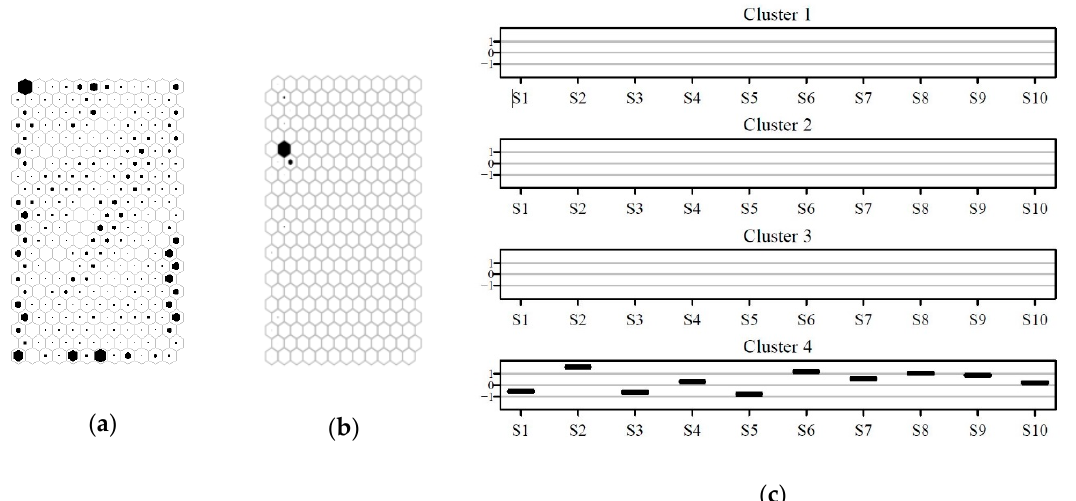
Figure 10. ( a ) Distribution of the building data on the map and ( b ) distribution of the external data on the map. The filling of each hexagon is proportional to the number of data mapping on the best matching unit (BMU) represented by the hexagon. ( c ) Interquartile ranges of the e-nose sensor responses for the external data set mapped on the SOM, grouped by cluster.